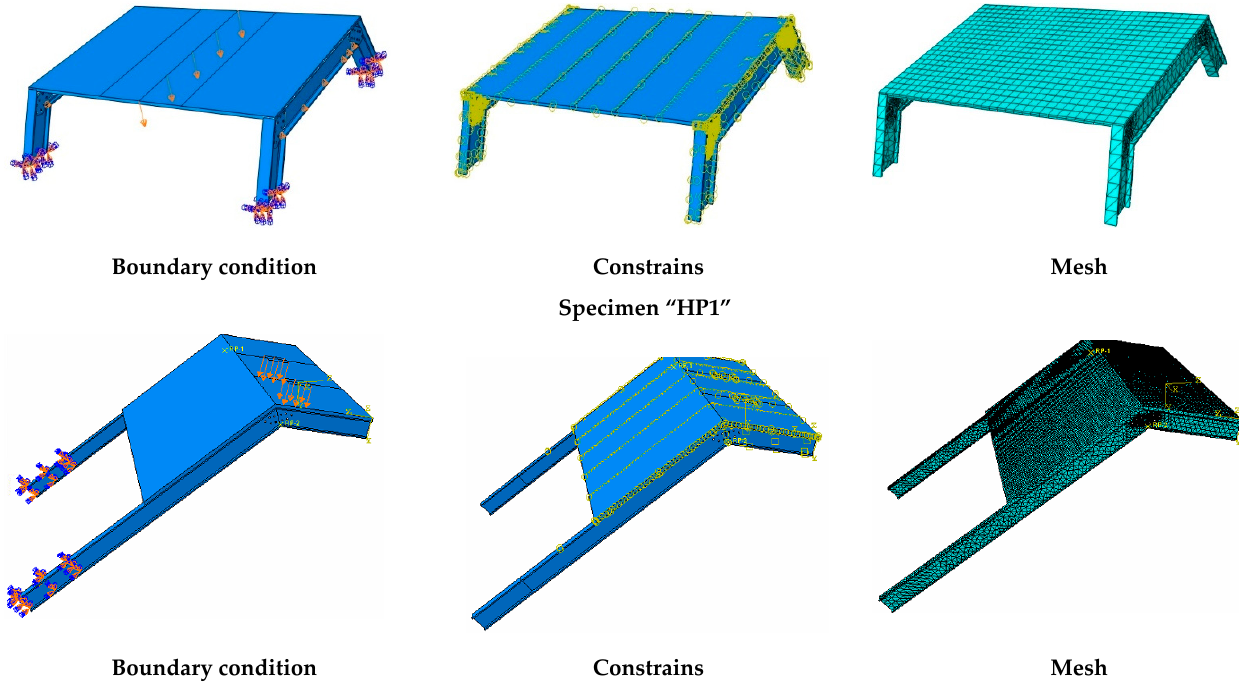
Figure 4. Overview of the numerical